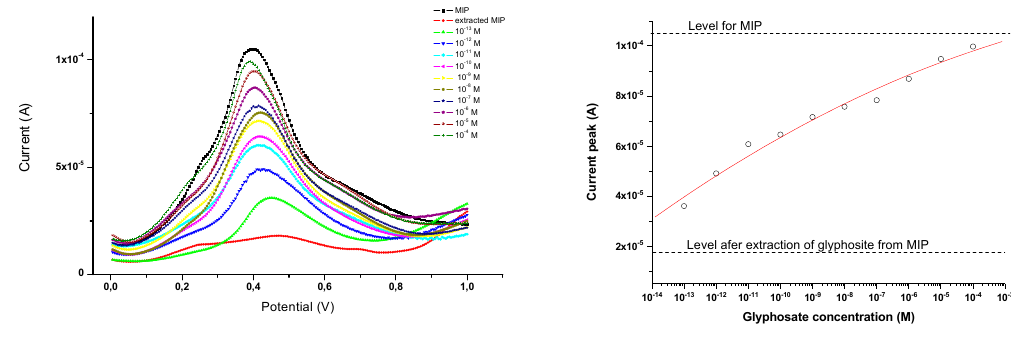
Figure 2. Follow up of glyphosate concentration variation, by square wave voltammetry ( left ), and current variation versus glyphosate concentration ( right ).